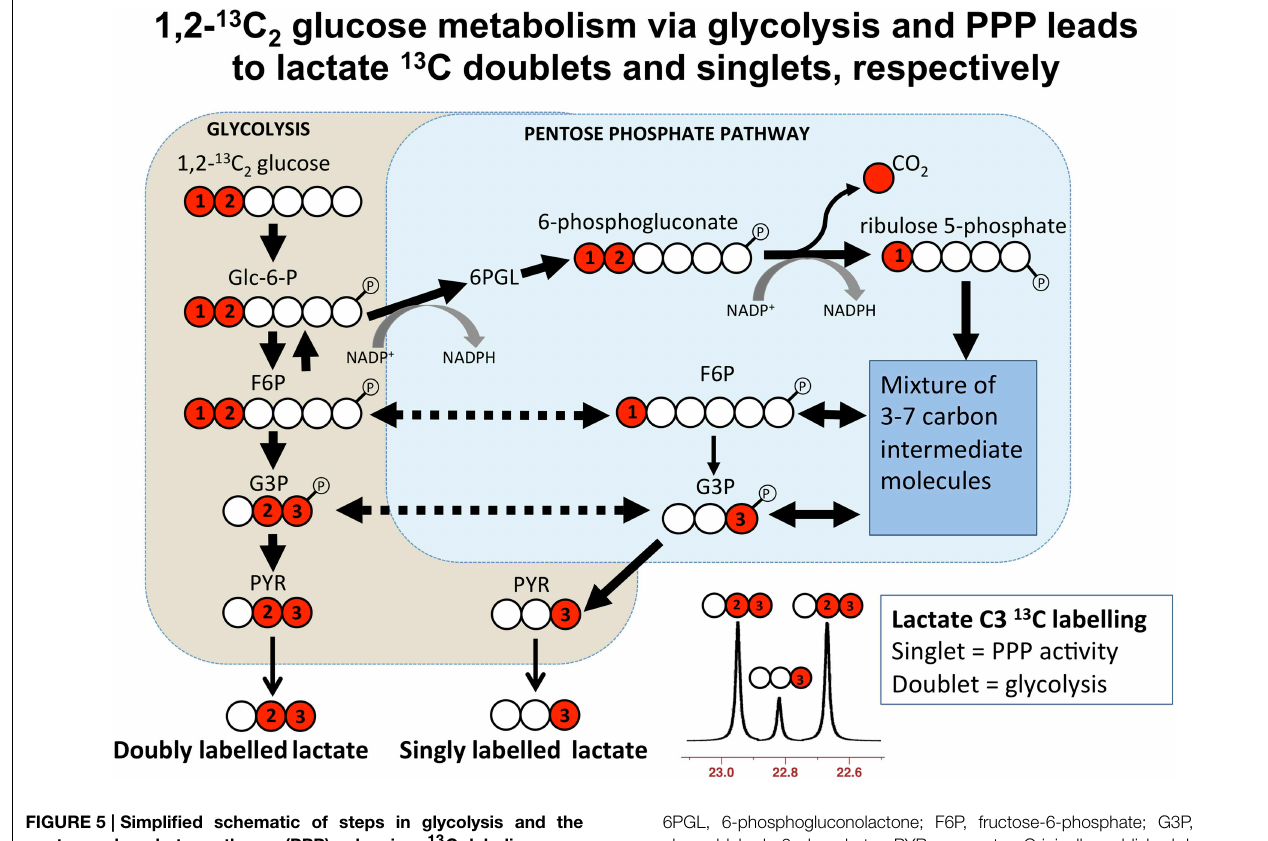
6PGL, 6-phosphogluconolactone; F6P, fructose-6-phosphate; G3P, glyceraldehyde-3-phosphate; PYR, pyruvate. Originally published